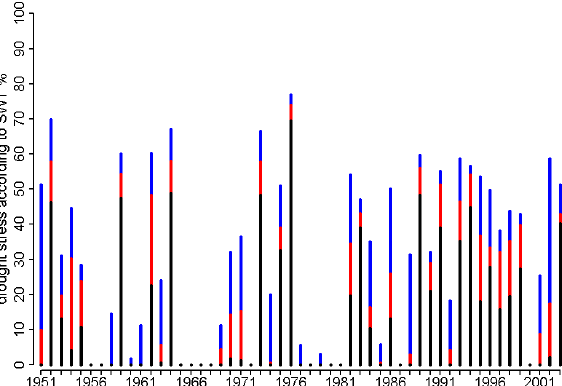
1 Fig. 3. Drought stress index ET Diff with thresholds of 4mm (blue), 6mm (red) and 8mm (black) for an even site and an available water capacity of 150mm; period 1951–2003; climate station “Deusel- bach”,